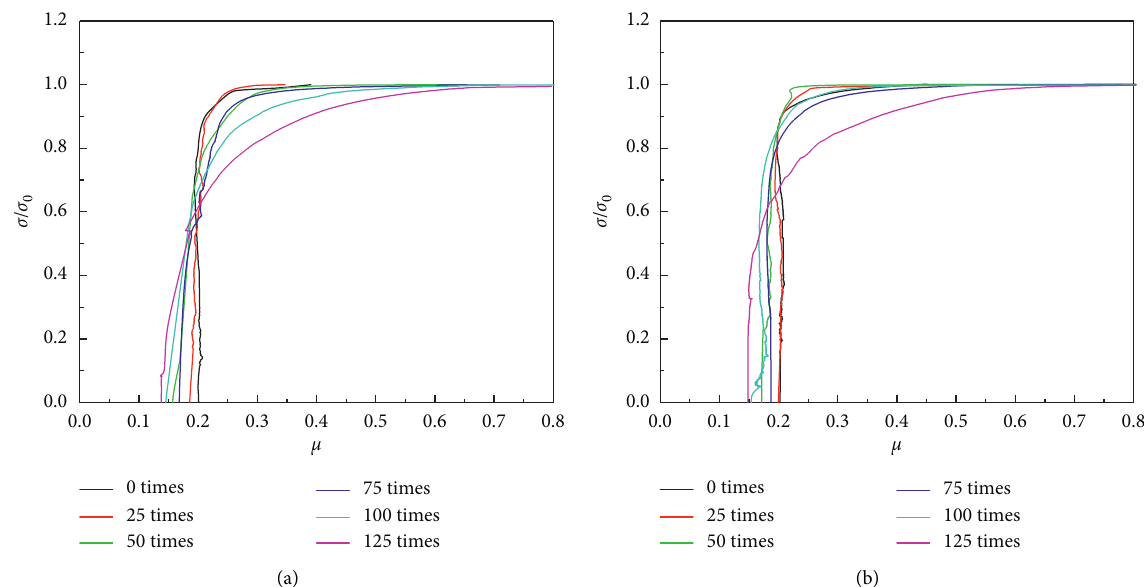
Figure 12: Relation between ( σ / σ